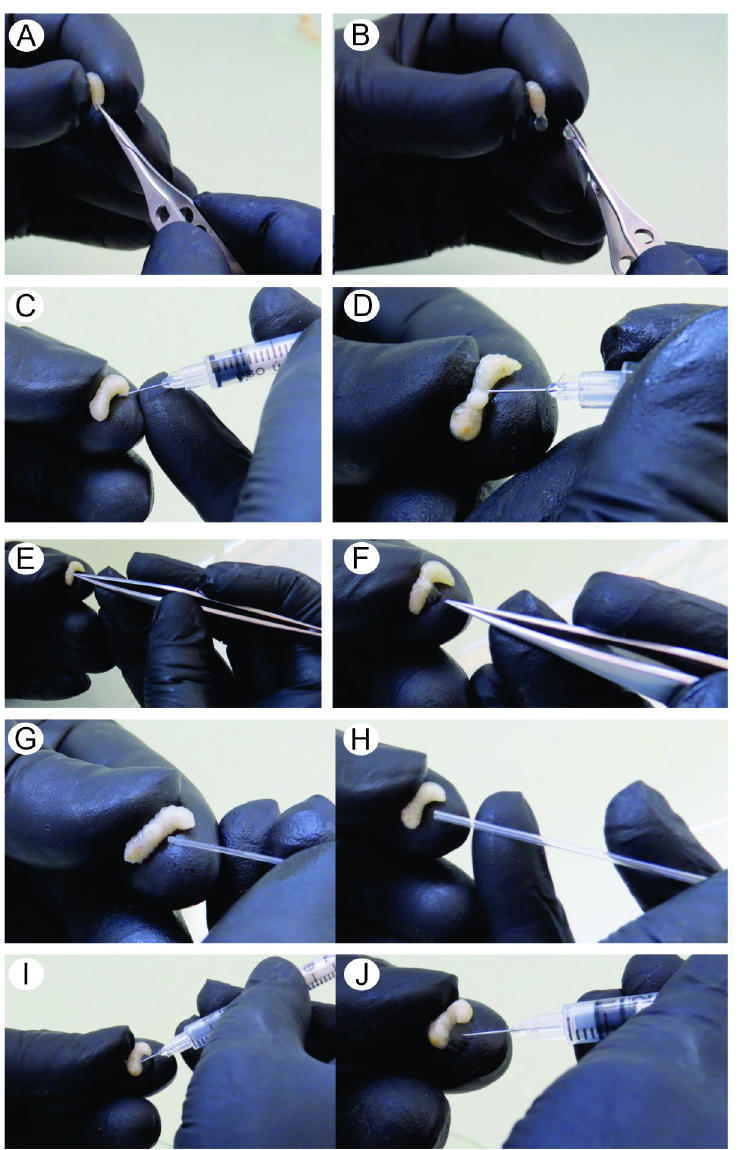
Fig 1. Different techniques for extracting hemolymph from the fifth instar larvae of A . mellifera . (A and B) Hemolymph extraction from larvae using ophthalmic scissors; (C and D) Hemolymph extraction from larvae using a 30G needle; (E and F) Hemolymph extraction from larvae using fine-tipped forceps; (G) Hemolymph extraction from larvae using a 0.22 mm capillary tube; (H) Hemolymph extraction from larvae using a 0.8–1.1 mm capillary tube; (I and J) Hemolymph extraction from larvae using a hypodermic